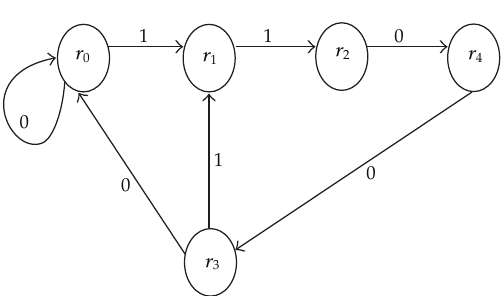
Figure 2: The corresponding graph G 14